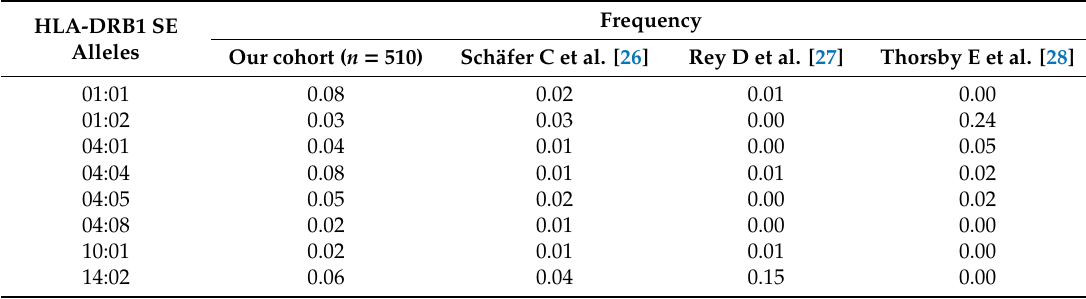
Table 2. Comparison between HLA-DRB1 SE alleles frequencies in previous reports and in our controls from